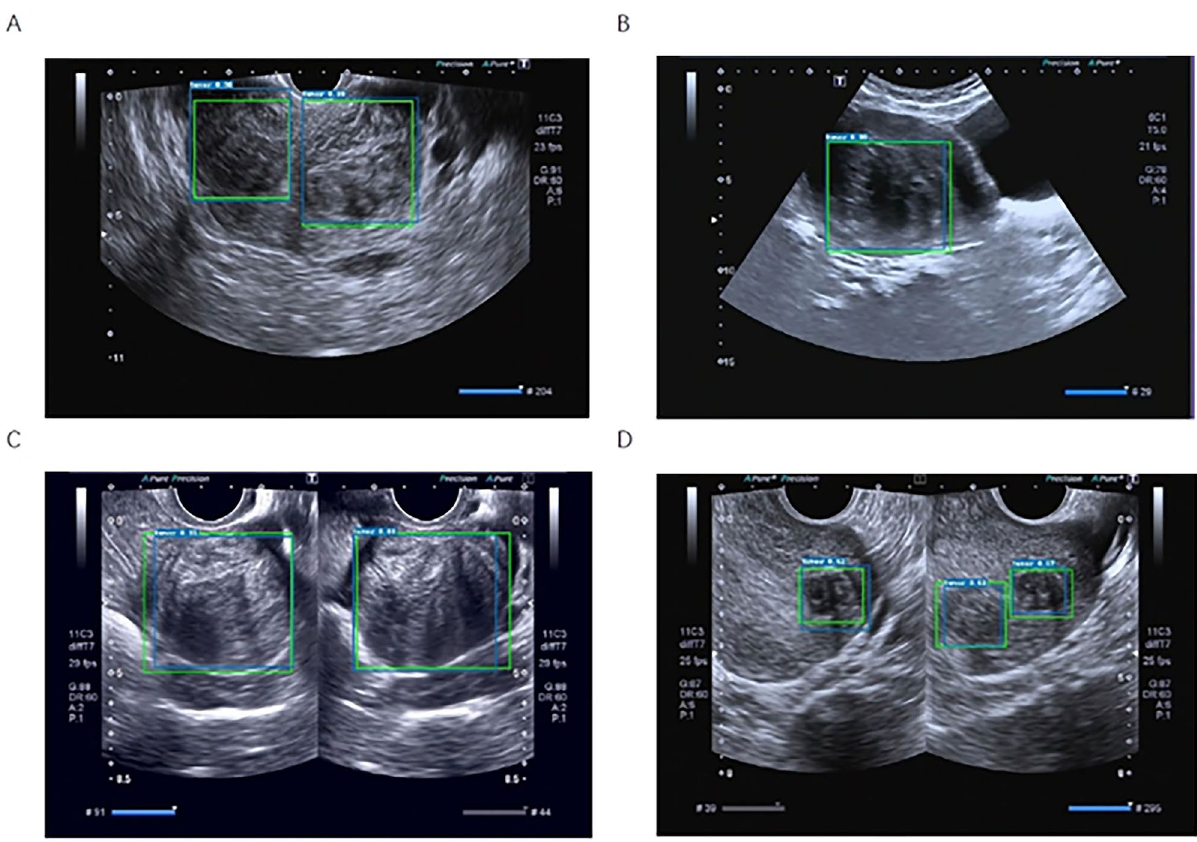
Figure 4. Uterine fibroid detection results. ( A ) Target detection results of multiple uterine fibroids in a single ultrasound image. ( B ) Target detection results of a single uterine fibroid in a single ultrasound image. ( C ) Target detection results of single uterine fibroids in patients with double ultrasound images. ( D ) Target detection results of multiple uterine fibroids in patients with double ultrasound images. Green boxes are the GT boxes annotated by our invited radiologists, and blue boxes are the boxes predicted by the trained model. The number marked in the upper left corner is the model detection confidence score.